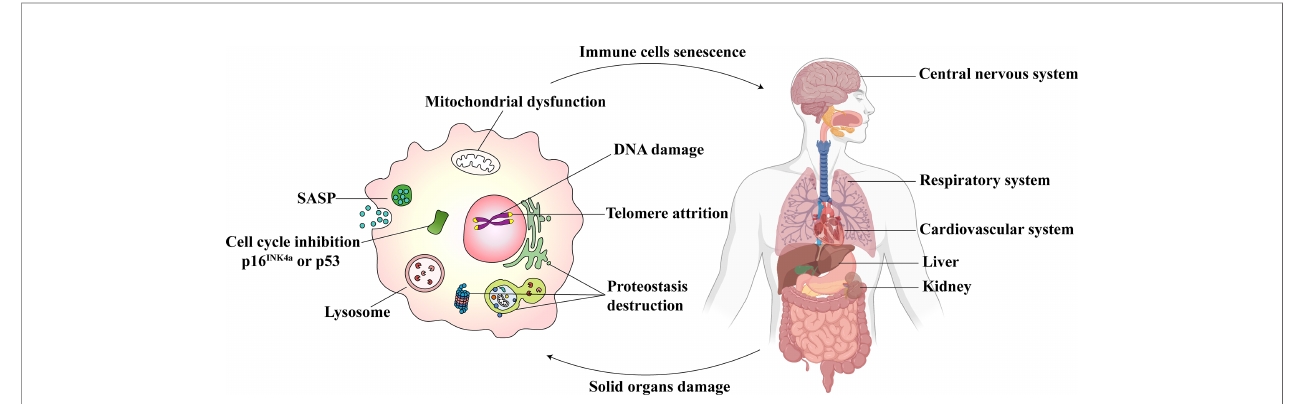
FIGURE 1 | Immunosenescence and parenchymal organ damage complement each other. The senescent immune cells (Left) show excessive oxidative stress in the mitochondria. The dysfunction, in turn, leads to DNA damage, telomere attrition, and proteostasis destruction. The cell cycle is inhibited. The senescence-associated secretory phenotype (SASP) is released, and lysosomal SA- b -gal accumulates. Immunosenescence could in fl uence the central nervous system, respiratory system, cardiovascular system, liver, and kidneys (Right). At the same time, the damage to these parenchymal organs may also cause immune